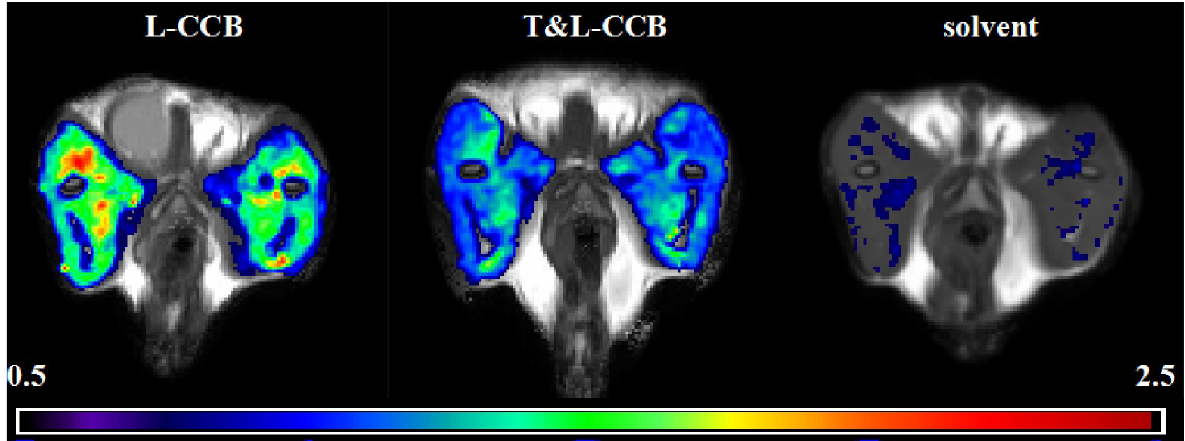
Fig 1. The antihypertensive effects of each drug and the solvent.